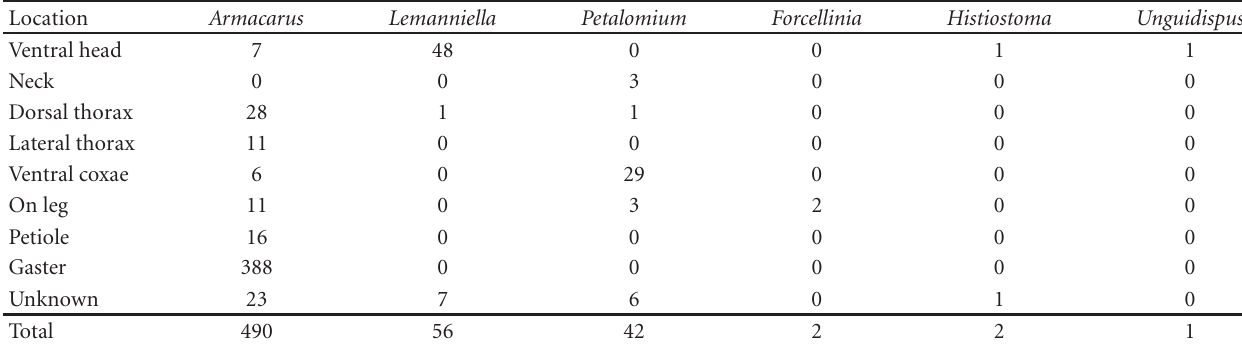
Table 5: Attachment site preferences for phoretic mite species on Messor pergandei